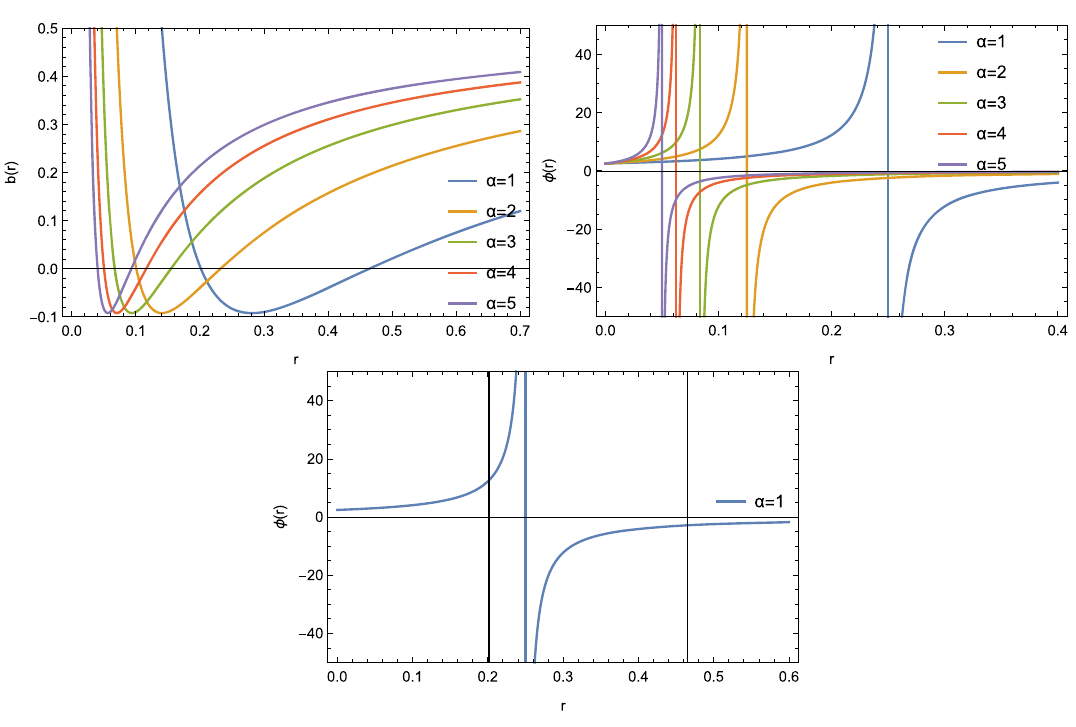
Fig. 2 The metric function b ( r ) (left) and the scalar field φ( r ) (right) for different values of the parameter α . Below, we plot the scalar field while the vertical lines represent the positions of the horizons for a particular value of α